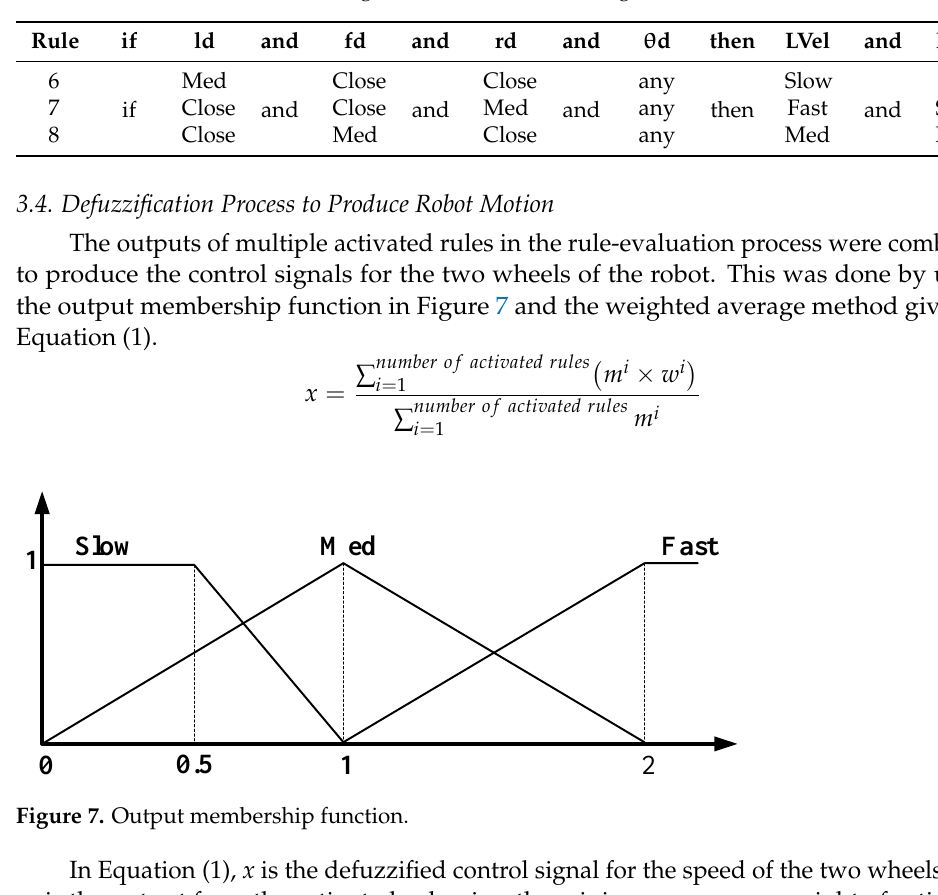
Table 3. Behavior rules for avoiding obstacles motion in navigation.